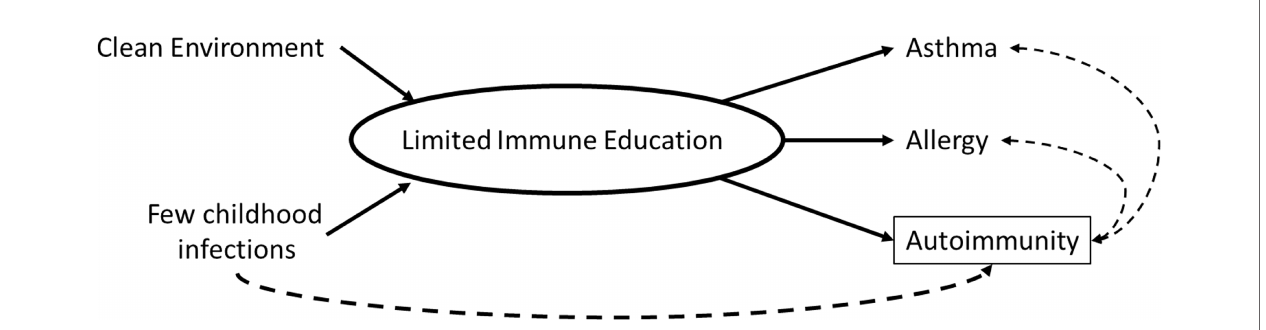
FIGURE 1 | Conceptual diagram of the relationship between hygiene hypothesis indicators and